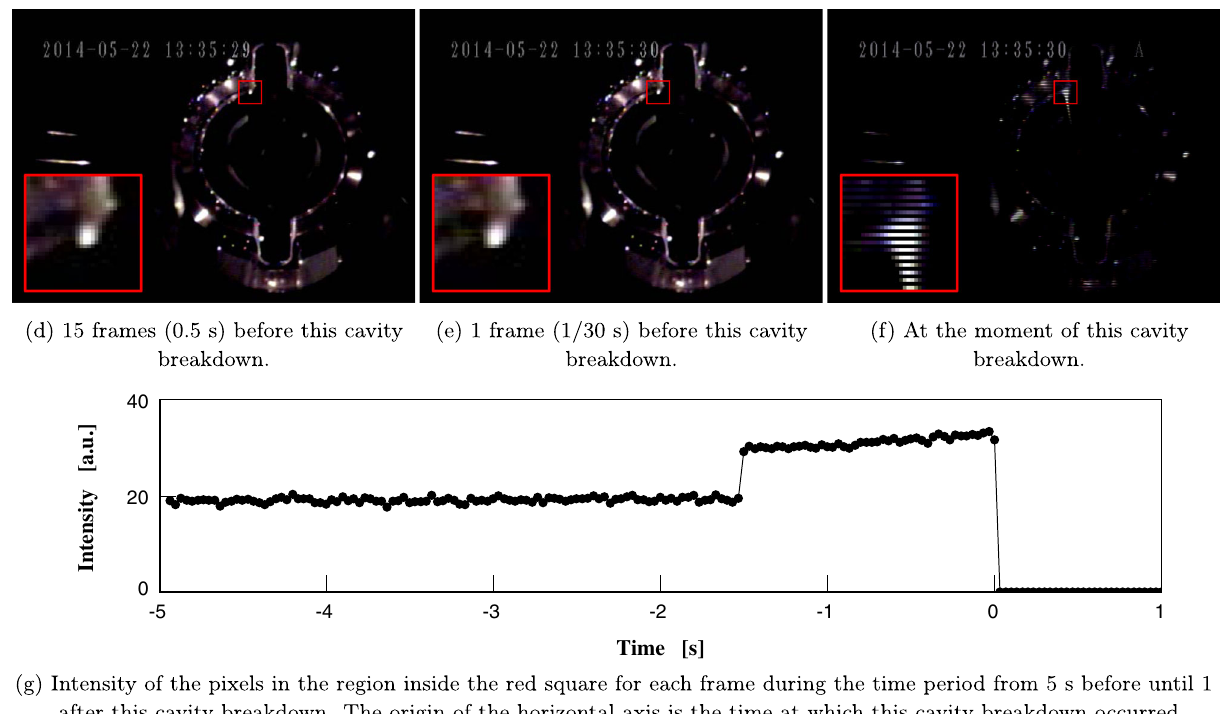
FIG. 15. Example of spot-type explosion events without a stable bright spot, accompanied by the sudden appearance of a new bright spot. (a) – (f) are snapshots, in chronological order, of the FEP recorded with TV camera 3 during the rf conditioning. The insets are magnified views of the region outlined by a red square. In this case, a new bright spot appeared at 11 o ’ clock 45 frames (1.5 s) before this cavity breakdown at V c ¼ 0 . 54 MV. A clear enhancement was observed in the intensity of the region outlined by a red square over the 46 frames, starting at the moment when the new bright spot appeared, as shown in